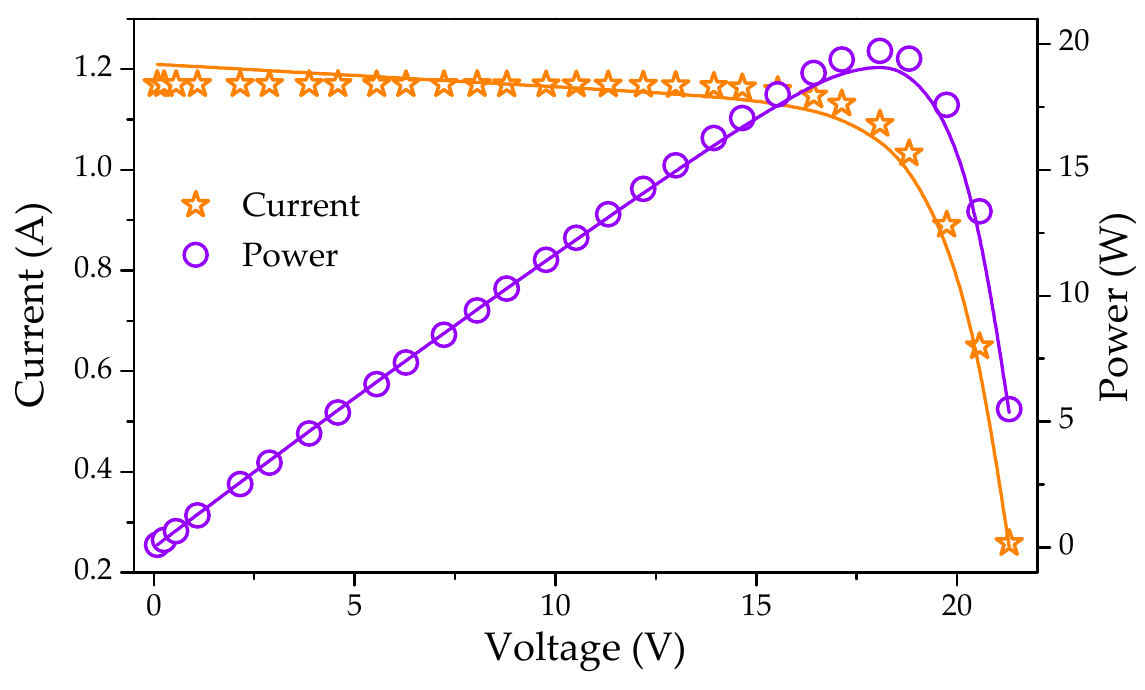
Figure 4. I-V and P-V characteristics curves for anticipated and experimental values for the SS2018 PV module. Symbols indicate measured data, while solid lines indicate optimized data.